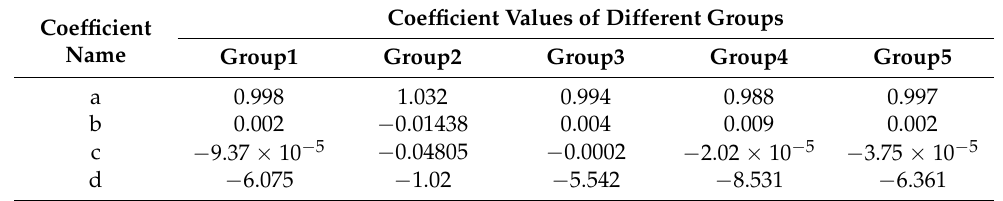
Table 5. Coefficient values of the exponential regression functions in different groups.